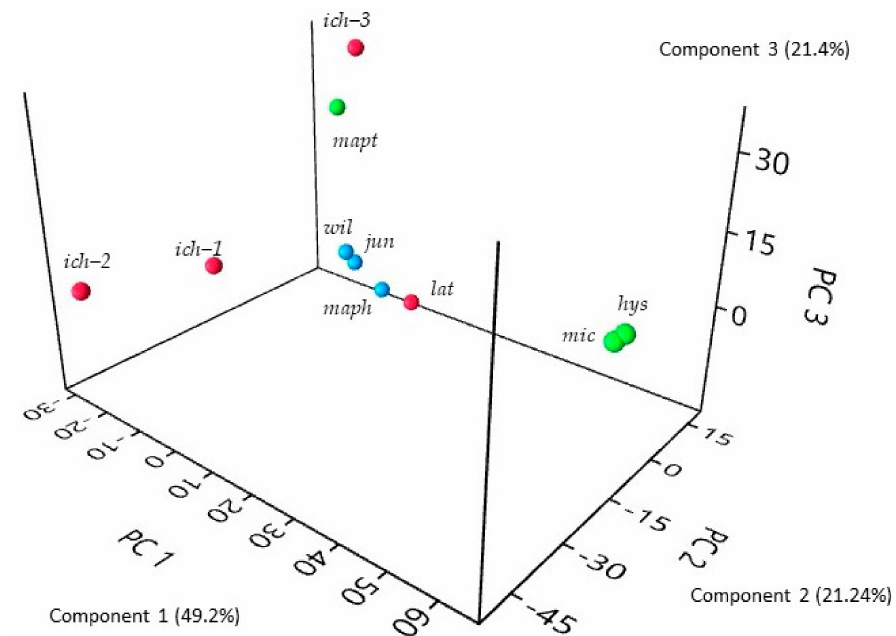
Figure 2. Three-dimensional Principal Component Analysis of leaf oil samples (components higher than 2%). Green: hys : C. hystrix , mic : C. micrantha , mapt : C. macroptera ; Red: lat : C. latipes , ich : C. ichangensis ; Blue: wil : C. wilsonii , jun : C. junos , maph : C. macrophylla . Melanesian Papeda ( C. macroptera